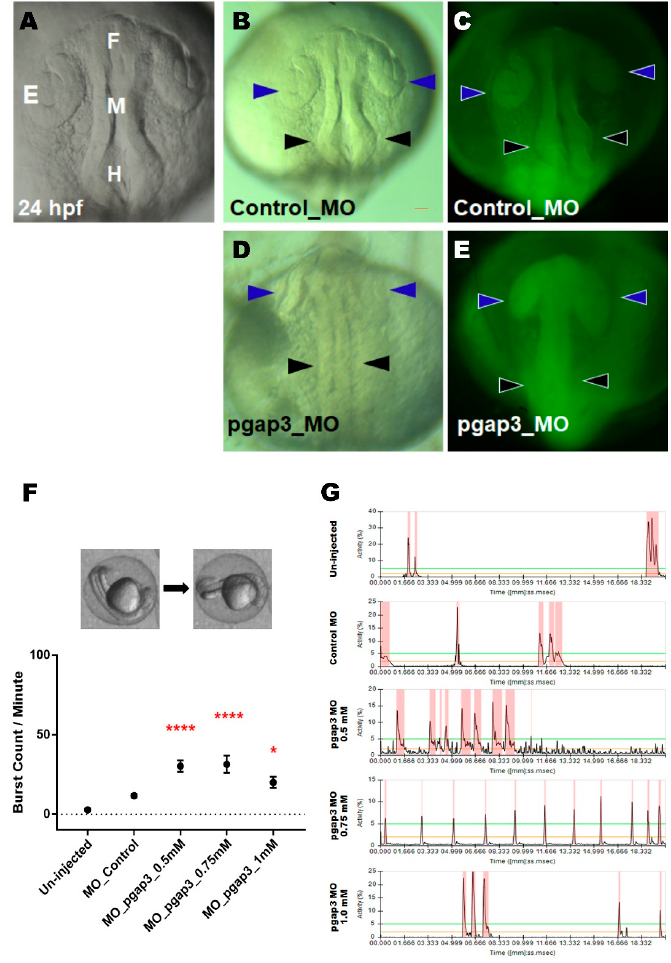
Figure 3. Zebrafish Pgap3 knockdown resulted in neural tube defect, delay in brain ventricles expansion, and seizure-related phenotype. Morpholino (MO)-based knockdown (0.5 mM) of zebrafish Pgap3 showed deficits in brain morphogenesis at 24 h post-fertilization (hpf) at the early stages of zebrafish brain development. Examination of pgap3 morphants demonstrated delayed development, fused neural tube into a continuous region, reduced expansion of the brain developing parts in the anterior-posterior direction, and defects in brain ventricles formation in comparison to control MO-injected group. ( A ) Illustration of zebrafish brain development at 24 hpf demonstrating the developing zebrafish brain composed of fore, mid and hindbrain. ( B , C ) Zebrafish control group image at brightfield and fluorescent FITC. ( D , E ) Zebrafish pgap3 morphant image at brightfield and fluorescent FITC. Arrowheads point to regions malformed in zebrafish pgap3 morphants. E: Eye; F: Forebrain; M: Midbrain; H: Hindbrain. Zebrafish imaging using Zeiss Lumar 12 stereomicroscope with ZEISS camera (Model Axiocam Erc 5s) at a magnification of 100 × , scale bar 10 µ m. ( F ) Zebrafish pagp3 morphants displayed significantly increased spontaneous head and tail coils at 24 hpf in comparison to the control group (un-injected); * p < 0.05, **** p < 0.0001. Locomotive behavior of zebrafish embryos after pgap3 MO injections assessed by spontaneous tail flicking and embryos movements that were measured by embryo burst count per minute and plotted into column graph for the mean with the standard error of the mean. N = 25, 34, 51, 36, 38 for the Control (un-injected), Control MO, pgap3 MO 0.5, 0.75, 1.0 mM, respectively. Statistical analysis was performed with one-way ANOVA followed by Dunnett’s test for multiple comparisons using GraphPad Prism (version 8.0). ( G ) Representative activity chart of zebrafish embryo at 24 hpf measuring movements through time for the zebrafish examined groups. Zebrafish imaging using Zeiss Lumar 12 stereomicroscope at a magnification of 10 × supplied with Imaging source camera DMK